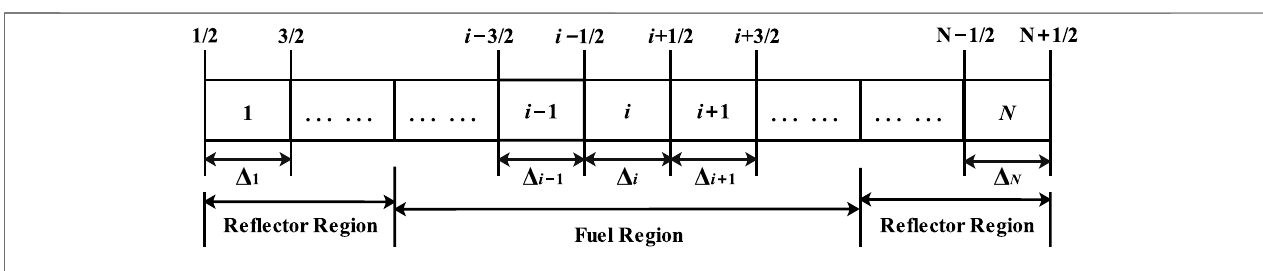
FIGURE 1 | Con fi guration of a typical LBE-cooled ADS.